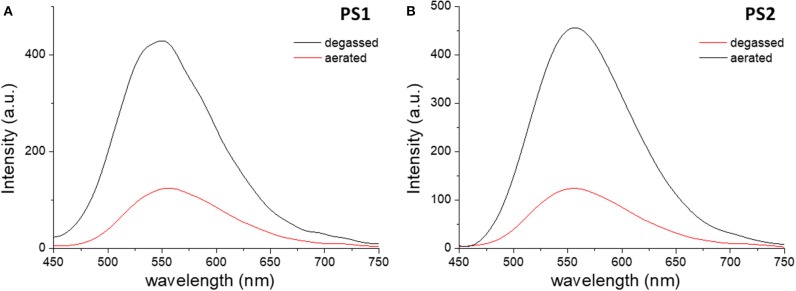
Steady-state emission spectra of PS1 (A) and PS2 (B) in aqueous suspension collected before (red) and after (black) degassing. λex = 340 nm.